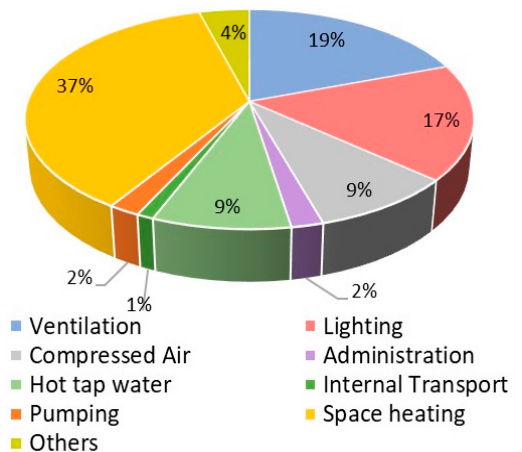
Figure 9. The share of EEU for support unit processes in the Swedish engineering industry.